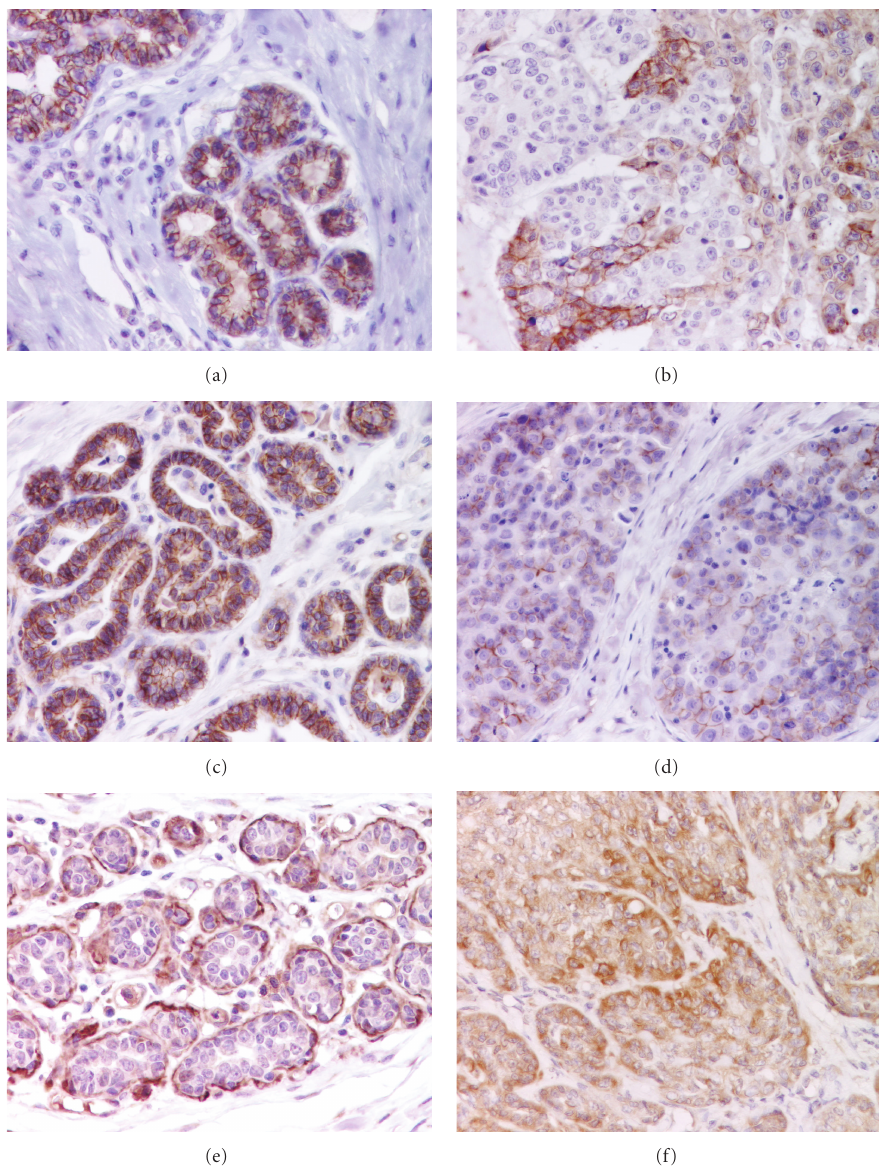
Figure 2: Immunohistochemical reactivity to adhesion molecules in canine mammary gland tissues. Normal mammary gland stained with antibodies to E-cadherin (a), β -catenin (c), and P-cadherin (e). Mammary carcinomas showing reduced expression for E-cadherin (b) and β -catenin (d), and aberrant expression for P-cadherin